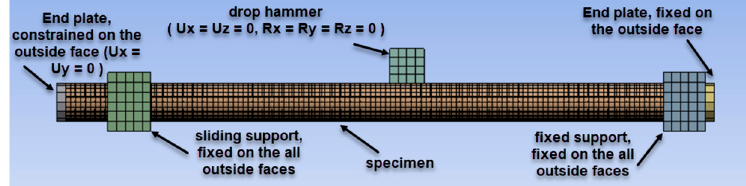
Figure 7. Schematic view of the FEM model and boundary conditions.